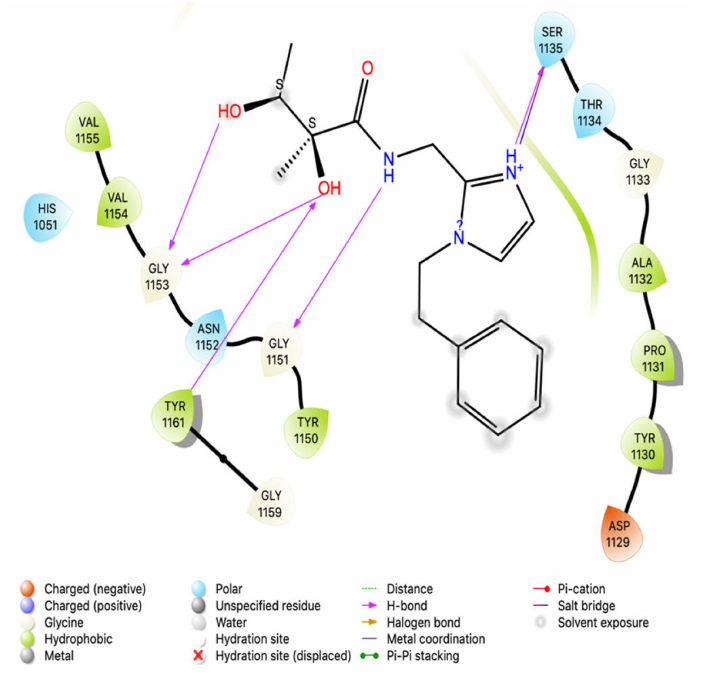
Figure 2. Interactions analysis of comp 1 with NS2B-NS3 protein of Zika virus.